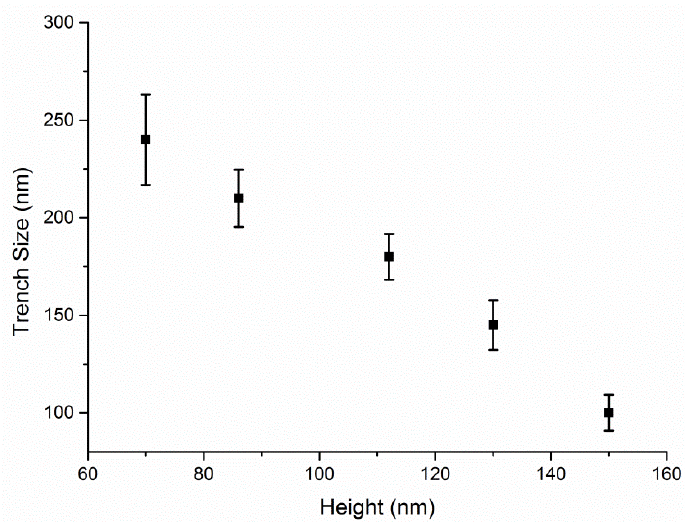
Figure 4. The widths of the trenches transferred onto an oxide layer by dry etching as a function of the initial polycarbonate pattern heights.